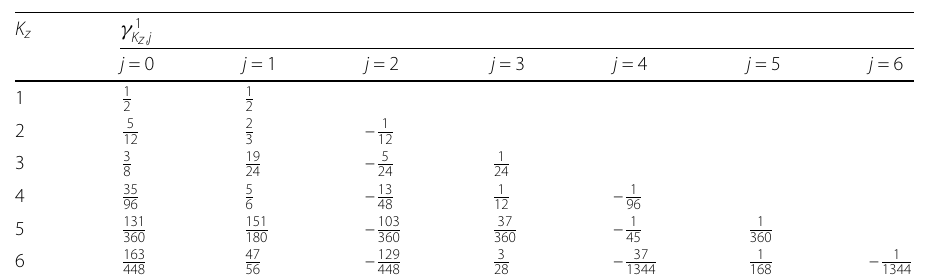
} K z until K z = j =0 K z , j